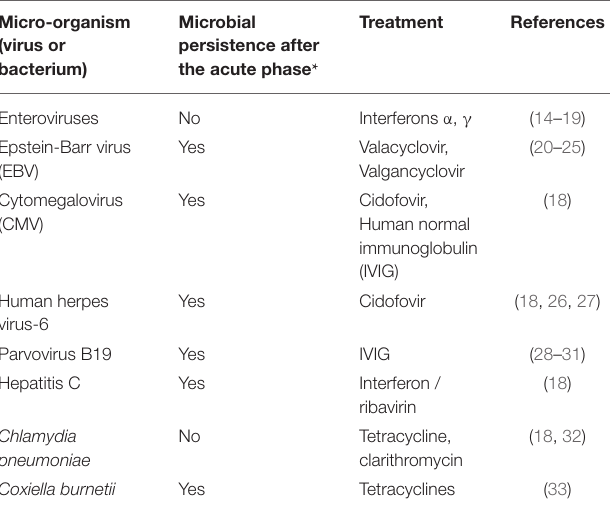
TABLE 1 | Microbial infections which have been shown to trigger